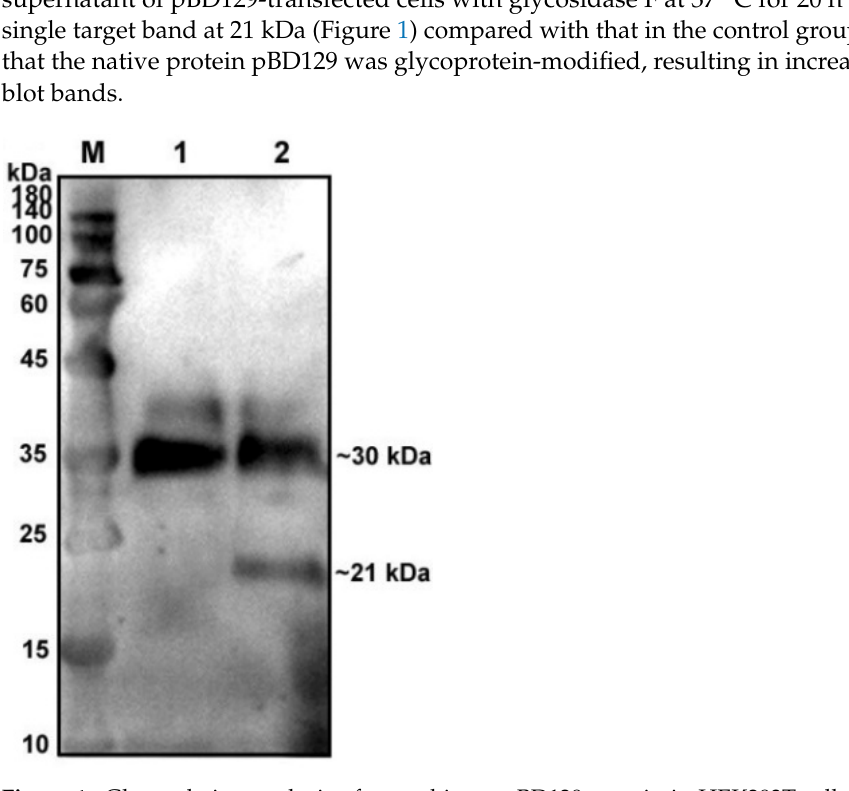
Figure 1. Glycosylation analysis of recombinant pBD129 protein in HEK293T cells. M: 180 kDa protein marker. Lane 1: supernatant of HEK293T cells transfected with pcDNA3.1(+)-pBD129 without glycosidase F treatment (Only a 30 kDa band). Lane 2: The supernatant of HEK293T cells transfected with pcDNA3.1(+)-pBD129 was treated with glycosidase F (two bands at 30 kDa and 21